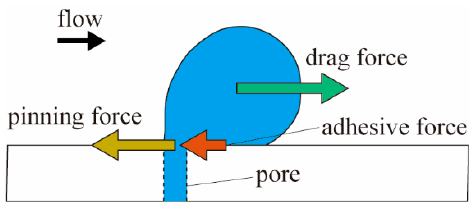
Figure 6. Force balance of the pinned water droplet at shedding.